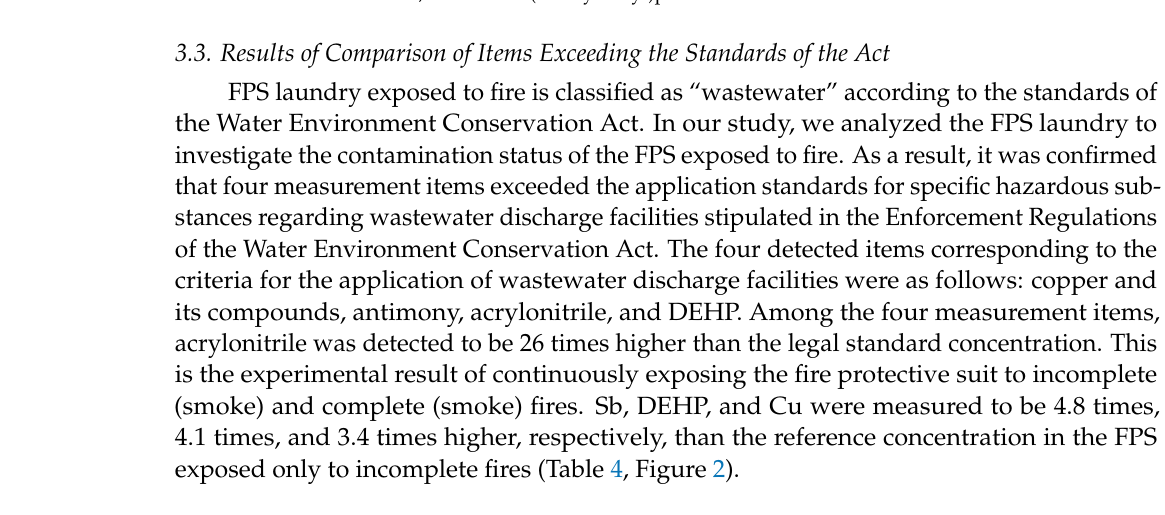
Table 4. Criteria for the application of wastewater discharge facilities for specific toxic substances in water and the maximum concentration in FPS laundry water.